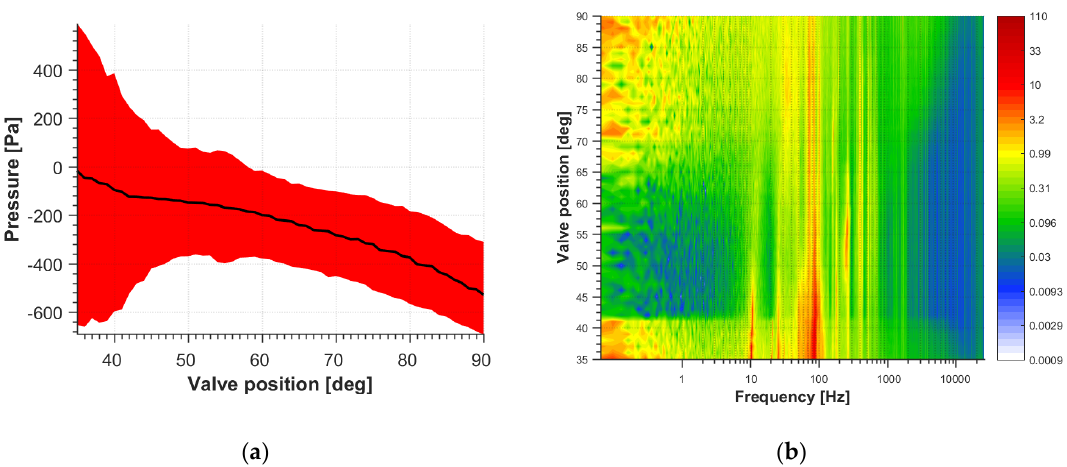
Figure 12. Pressure variation depending on the valve position measured at the diffuser at inlet rotational speed 110 Hz. ( a ) The left plot represents the min-to-max plot (red) and the pressure average value (black). ( b ) The right plot represents the spectral map with the colormap in the logarithmic scale.